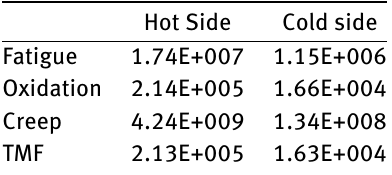
Table 1: Minimum cyclic lives for individual damage